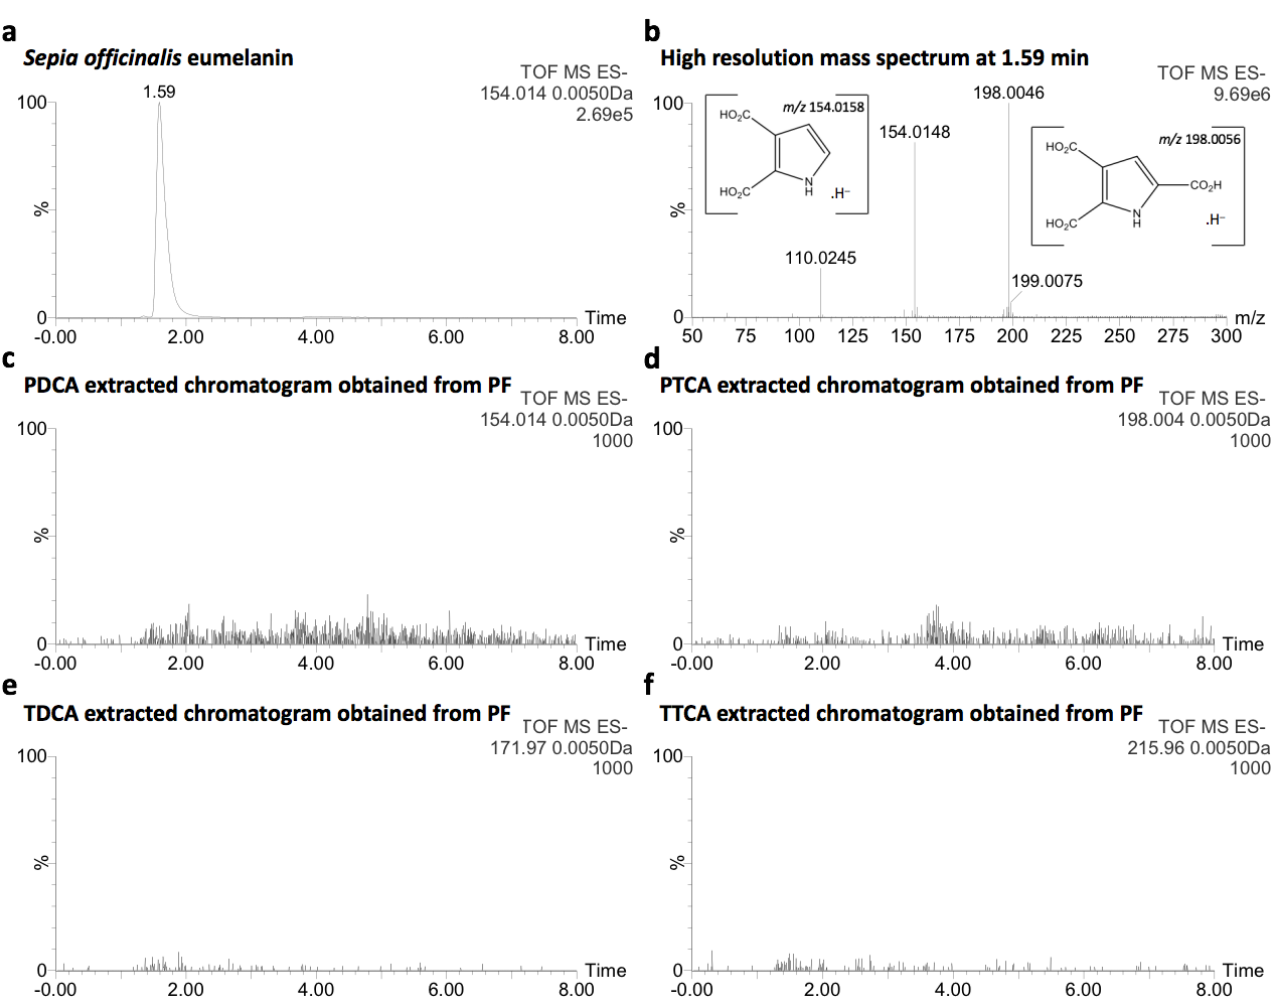
Figure 3. ( a , b ) Extracted chromatogram of Sepia officinalis eumelanin oxidation products and the corresponding high resolution mass spectrum; ( c – f ) Extracted chromatograms of melanins oxidation products from PF, background noise.